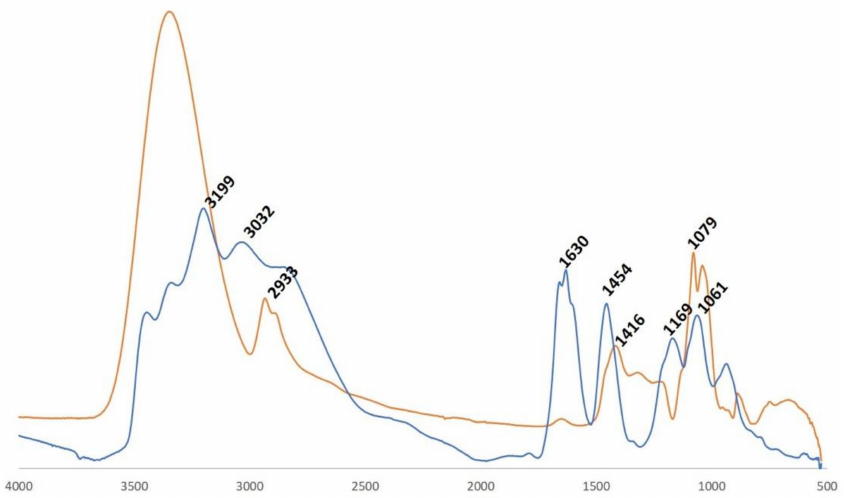
Figure 1. FT-IR spectra of sorbitol (orange) and modified sorbitol (blue).